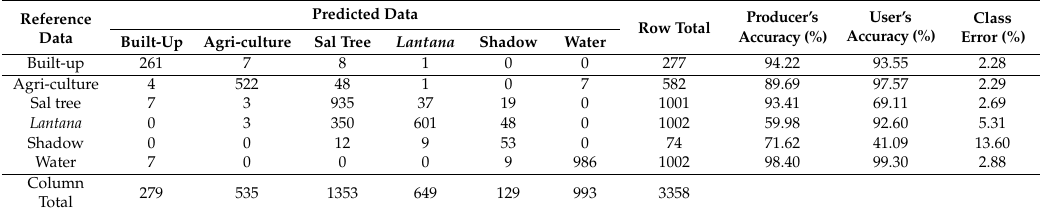
Table 4. Classification accuracy matrix for